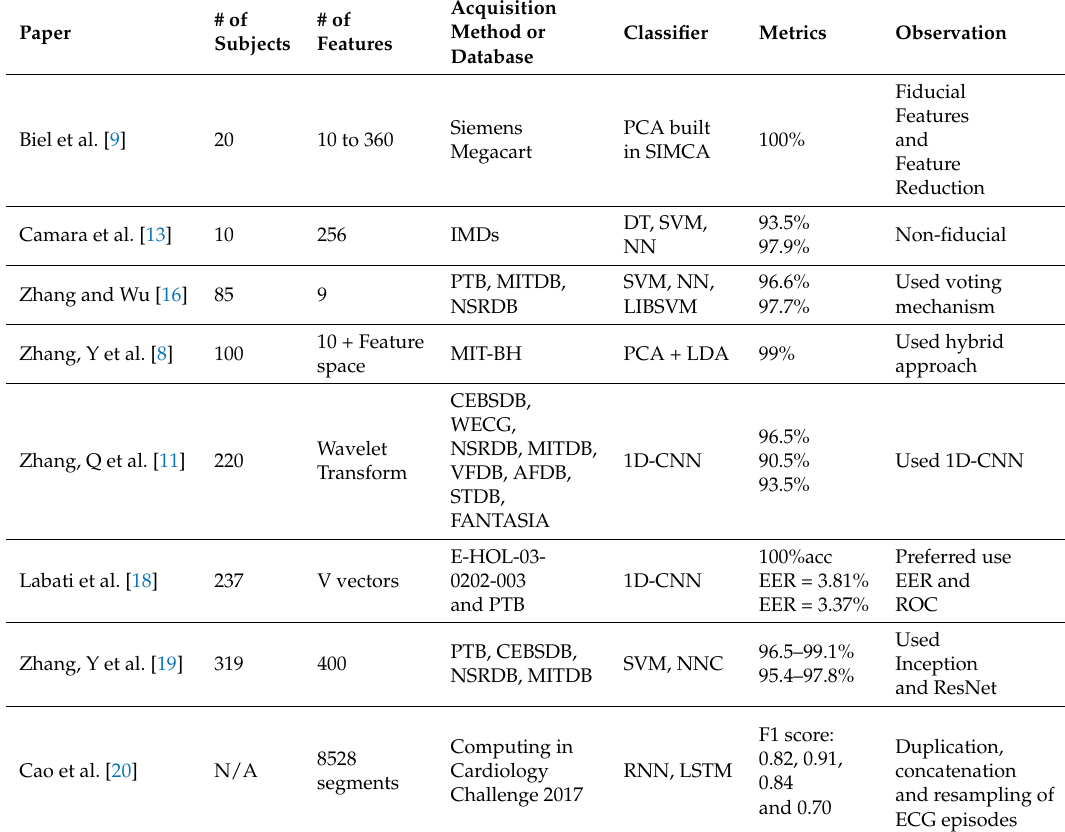
Table 1. Related Works